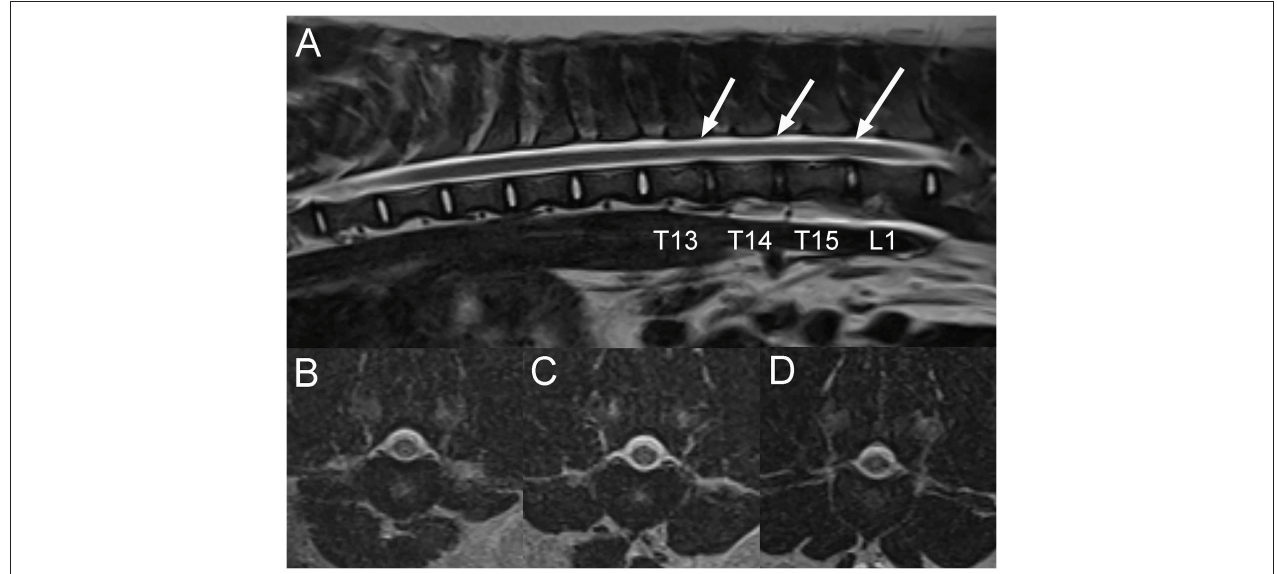
FIGURE 5 | Sagittal T2W (A) and transverse T2W images of the thoracolumbar vertebral column at the level of T13-14 (B) , T14-15 (C) and T15-L1 intervertebral disc spaces in a 1-year-old pig with acute T3-L3 myelopathy (Case 5). There is mild decrease in normal T2W signal intensity of the T13-14, T14-15 and T15-L1 intervertebral discs compared to the other ones and very mild protrusion of the T15-L1 and T13-14 intervertebral discs. There are faint linear intramedullary T2W hyperintense areas compared to the spinal cord over the caudal thoracic and cranial lumbar vertebral column, mostly centered over the T15-L1 intervertebral disc space, less obvious over the T13-14 and T14-15 intervertebral disc spaces ( A ; arrows), and located within the central to right lateral aspect of the spinal cord on transverse images (B–D) . Based on clinical presentation and imaging findings, a presumptive diagnosis of either fibrocartilaginous embolism (FCE) or acute non-compressive nucleus pulposus extrusion (ANNPE) was made.